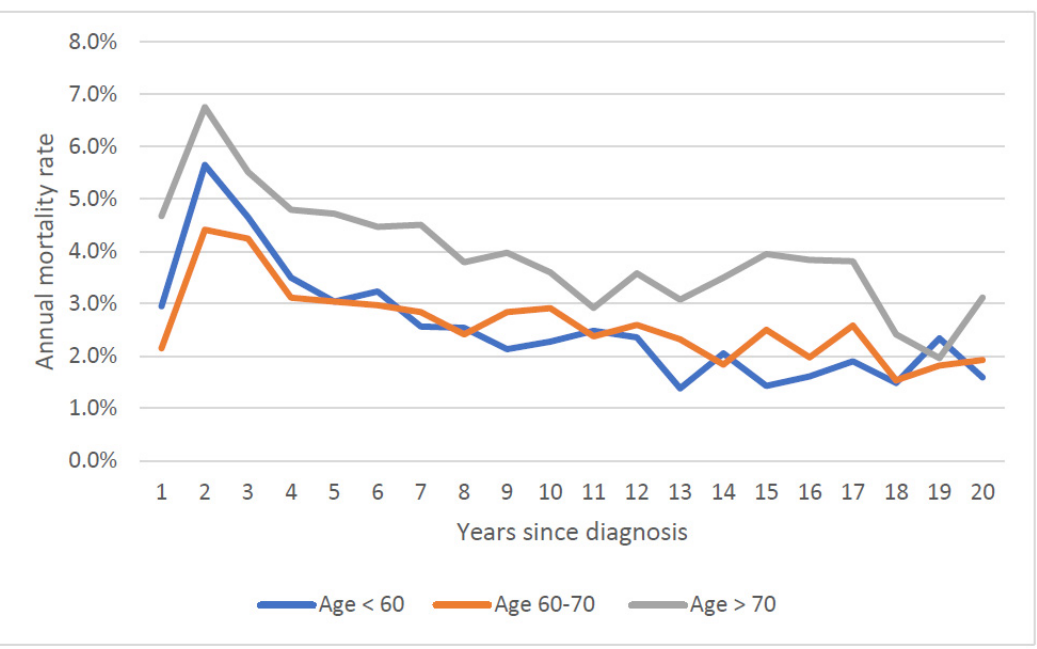
Figure 3. Annual prostate specific mortality rate by age of diagnosis (Gleason Score ≤ 6).